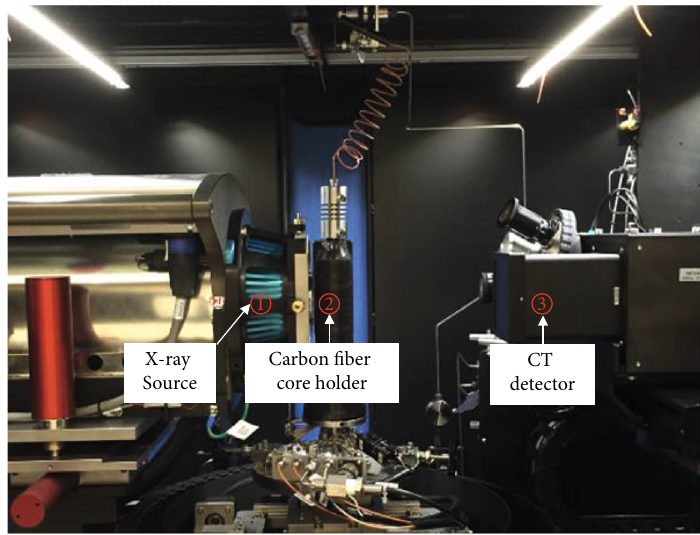
Figure 1: Experimental